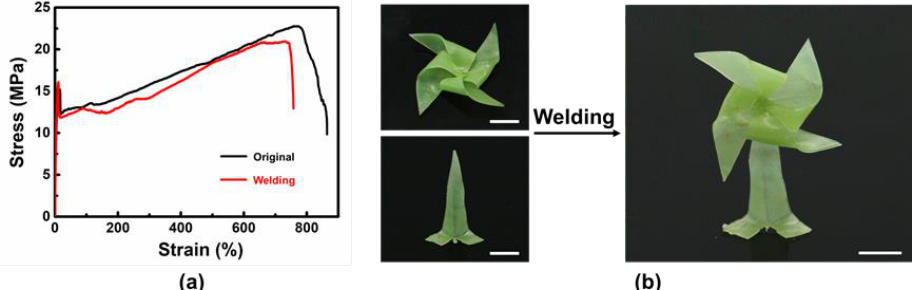
Figure 8. The self-welding of metallo-supramolecular networks. ( a ) The mechanical properties of an original sample and a welded sample. ( b ) A windmill tower shape obtained from self-welding of different parts, scale bar: 1cm.